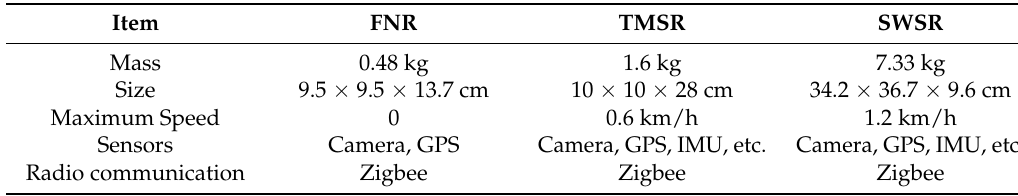
Table 1. Specification of the ground robots.